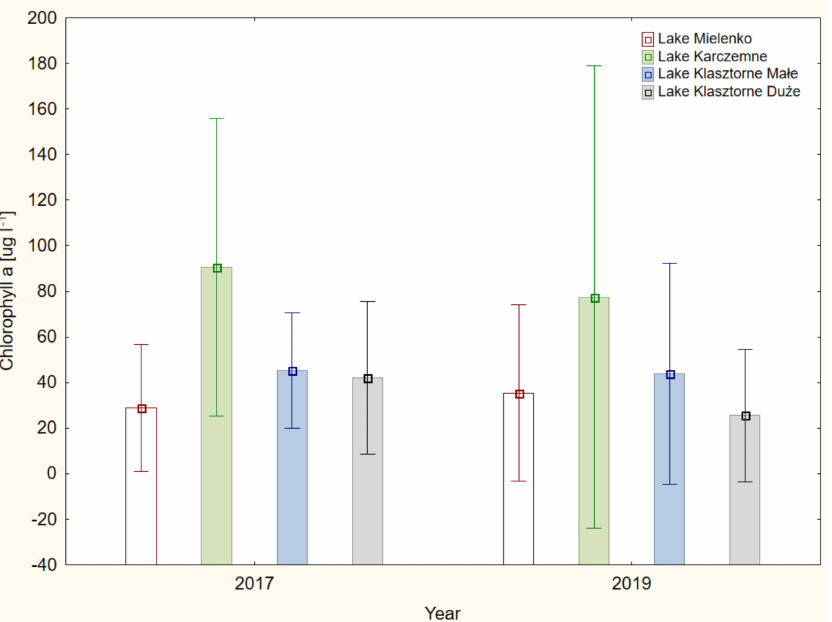
Figure 7. Mean annual values of chlorophyll a in the water of Kartuzy lake complex in selected research years (box ± SEM, whisker plots ± Standard Deviation).